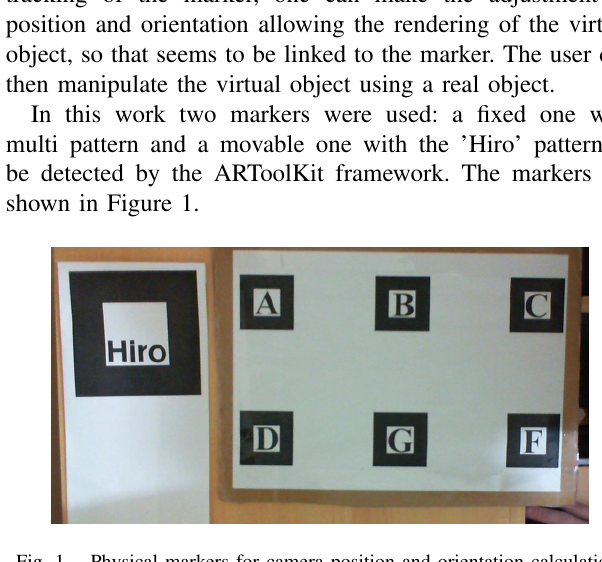
Fig. 1. Physical markers for camera position and orientation